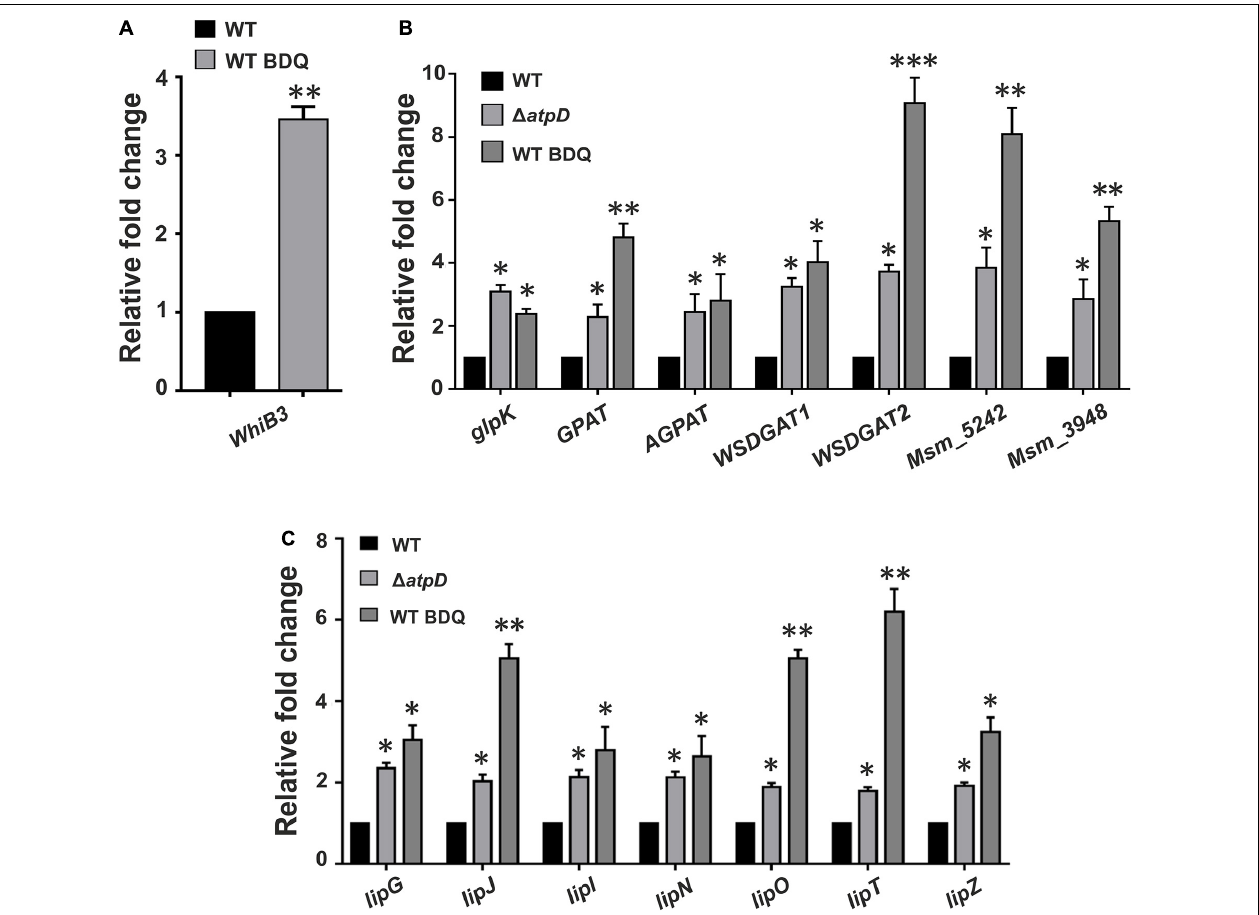
FIGURE 8 | Bedaquiline-treated wild-type M. smegmatis shows increased WhiB3 expression coupled with TAG accumulation and lipase gene upregulation. Panel (A) shows the mRNA transcript level of redox sensor WhiB3 in wild-type M. smegmatis cell either without (WT) or with bedaquiline (BDQ)-treatment (WT BDQ); for comparison with the M. smegmatis atpD knock-out strain, refer to Figure 2A . Panel (B) shows the relative mRNA transcript levels of genes belonging to Kennedy pathway such as glycerol kinase ( glpK ), glycerol-3 phosphate acyl transferase ( GPAT ), acylglycerol phosphate acyltransferase ( AGPAT ), two wax ester synthase/acyl-CoA: diacylglycerol acyltransferase ( WSDGAT ) and the TAG synthase genes ( MSMEG_3948 and MSMEG_5242 ; these are homologues of tgs1 in M. tuberculosis ) in M. smegmatis WT, its atpD knock-out variant ( (cid:49) atpD ), and the bedaquiline (BDQ)-treated wild-type M. smegmatis (WT BDQ). Panel (C) shows the relative mRNA transcript levels of the lipase genes ( lipG, lipJ, lipI, lipN, lipO, lipT , and lipZ ) in M. smegmatis WT, atpD knock-out ( (cid:49) atpD ), and the bedaquiline (BDQ)-treated wild-type M. smegmatis (WT BDQ). In all of the panels, the mRNA transcript in the case of untreated WT is taken as 1 for comparison. In each panel, the data represent an average of at least three independent experiments. Error bars represent standard deviation. ∗ P -value < 0.05; ∗∗ P -value < 0.01; ∗∗∗ P -value <